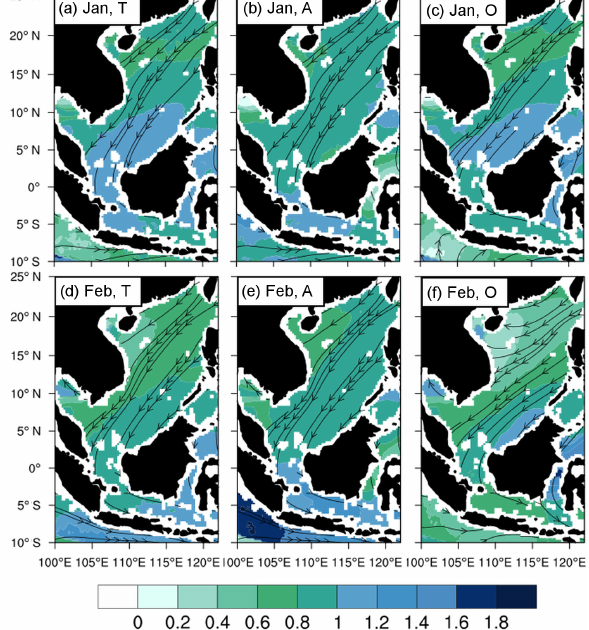
Figure 4. Like Fig. 3 but for (a–c) January, and (d–f)